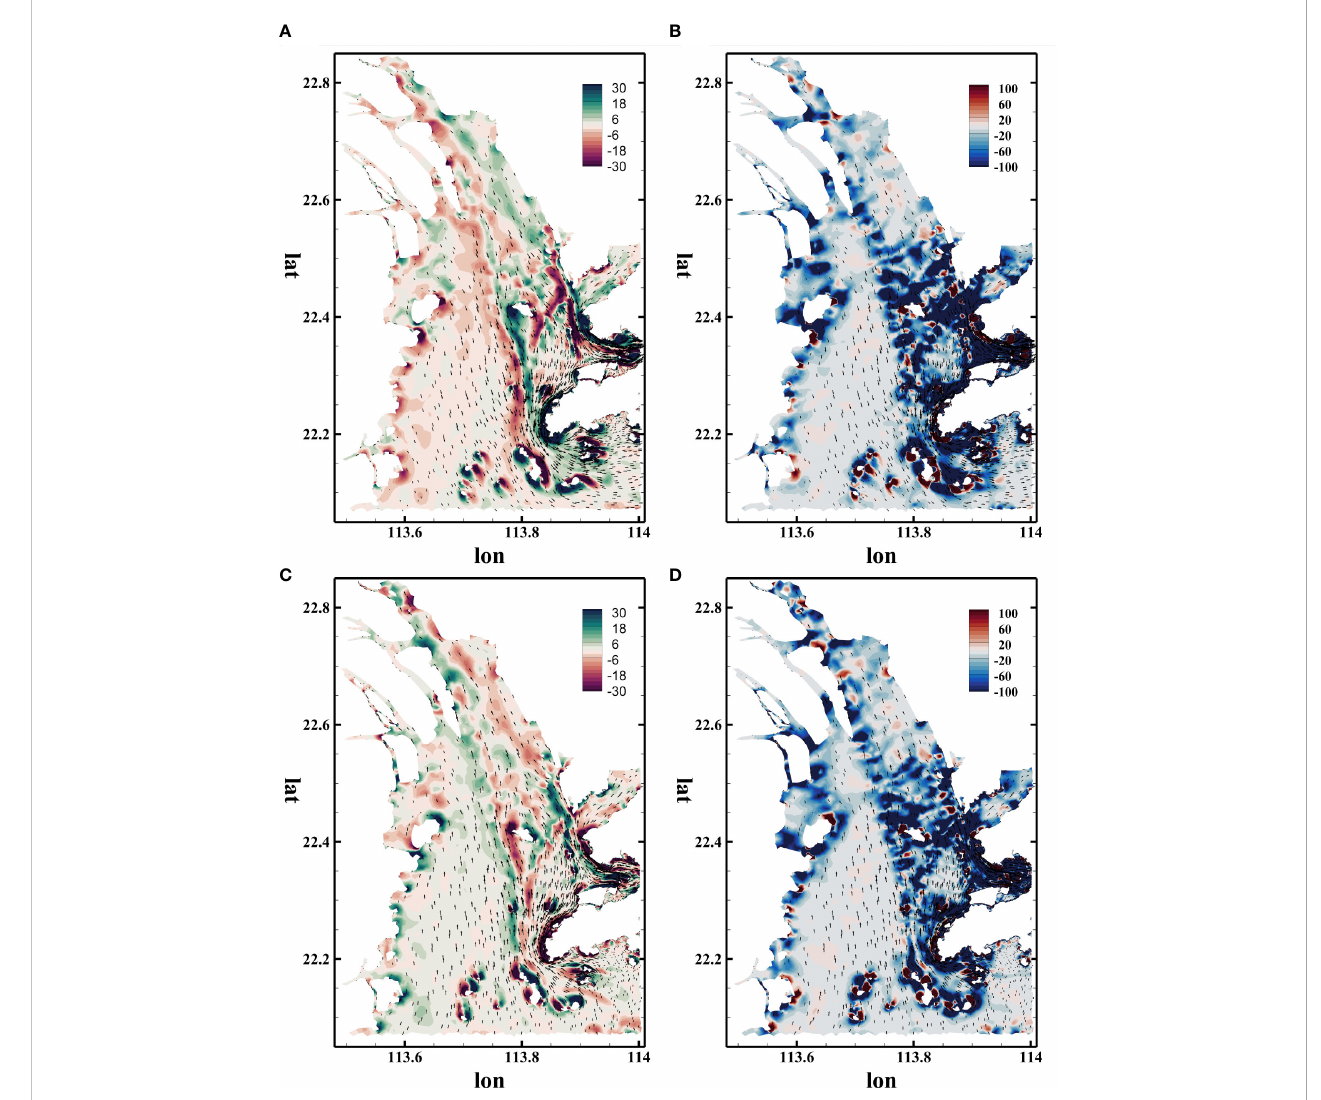
FIGURE 3 Maps of vortices on surface layer using different extraction methods during ebb tide and fl ood tide: vorticity (A) and Q -criterion maps (B) during ebb tide; (vorticity (C) and Q -criterion maps (D) during fl ood